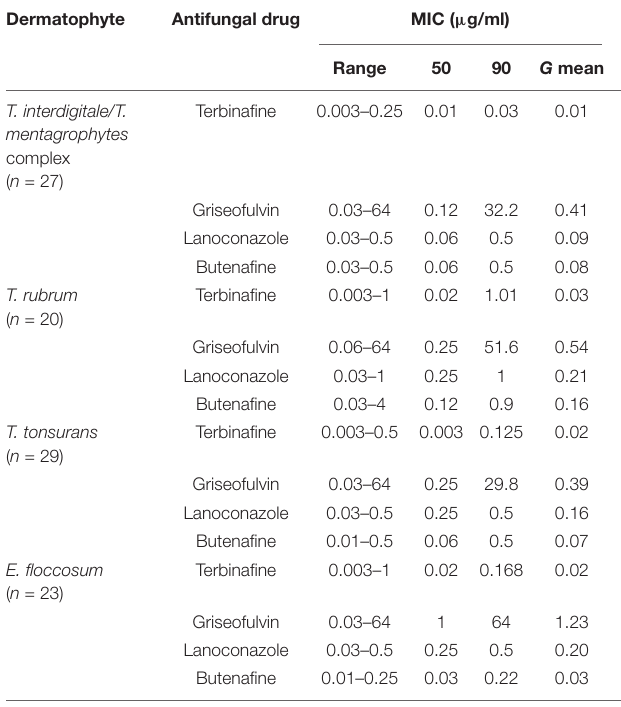
TABLE 4 | Susceptibility of 95 clinical isolates and four reference strains of dermatophytes to four antifungal agents.